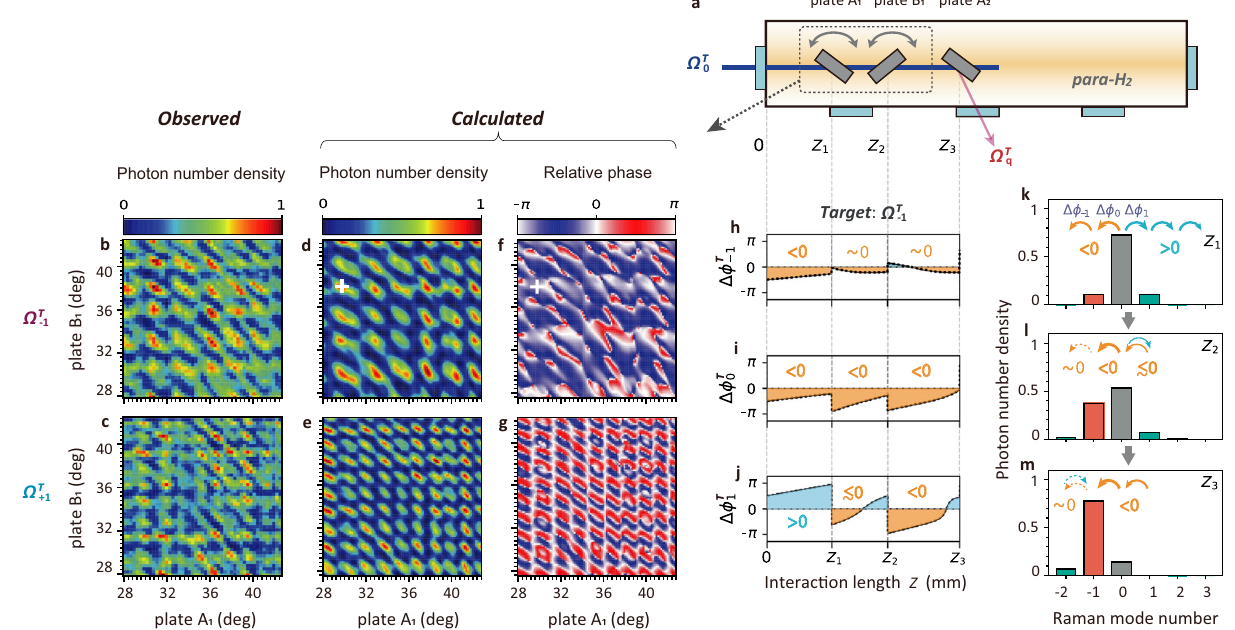
Fig. 2 Physical mechanism of the engineered Raman-resonant four-wave-mixing (Rr-FWM) process. a Experimental layout for the apparatus used for studying the physical mechanism. The angles of plate A 1 (at length Z 1 = 45mm) and plate B 1 (at length Z 2 = 95 mm) were each precisely adjusted with an angular resolution of 0 : 015 (cid:5) in a range of 35 ± 7 : 5 (cid:5) . The high-order Stokes and anti-Stokes generations initiated from the laser radiation, Ω T , were 0 monitored by beam re fl ection with plate A 2 at Z 3 (145 mm). Here, Z 1 , Z 2 , and Z 3 are interaction lengths in gaseous para-hydrogen. b , c Contour plots of the observed photon number densities at b Ω T (cid:1) and c Ω T þ as a function of the insertion angles of plates A 1 and B 1 . 1 implies unity quantum conversion 1 1 ef fi ciency. d – g Numerically calculated photon number densities at d Ω T (cid:1) and e Ω T þ and corresponding relative phases, f Δ ϕ T (cid:1) and g Δ ϕ T þ , at each angular 1 1 1 1 in this explored range. h – j Relative condition of plates A 1 and B 1 . The white cross in d indicates the point that maximizes the photon number density at Ω T (cid:1) 1 phases, Δ ϕ T q ( q = − 1, 0, 1), at the condition marked by the white cross in d , manipulated as a function of the interaction length, Z . k – m Photon number density distributions among the Raman modes, Ω T q ( q = − 2 to 3), calculated at the conditions marked by the white cross in d . The arrows and their thicknesses respectively show how the signs and magnitudes of the relative phases, Δ ϕ T q , are manipulated to enlarge the photon number density, Ω T (cid:1) , as a 1 function of the interaction length, Z